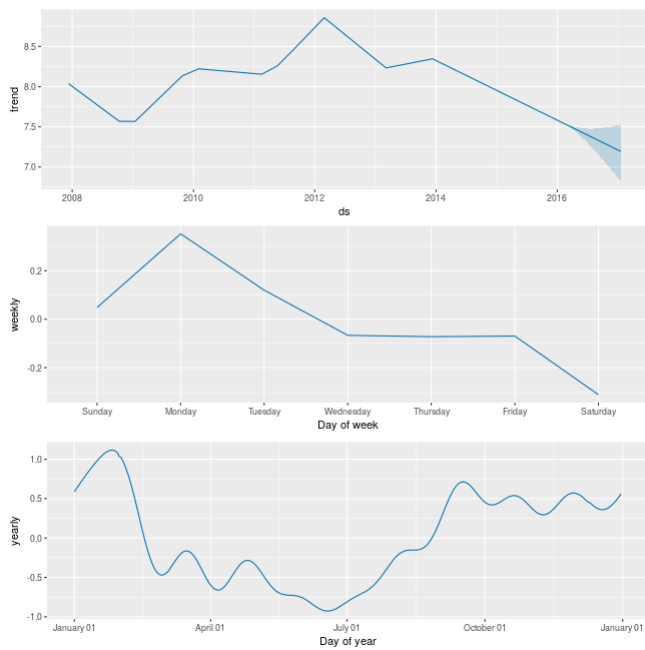
Figure 2. Component plot which describes the model